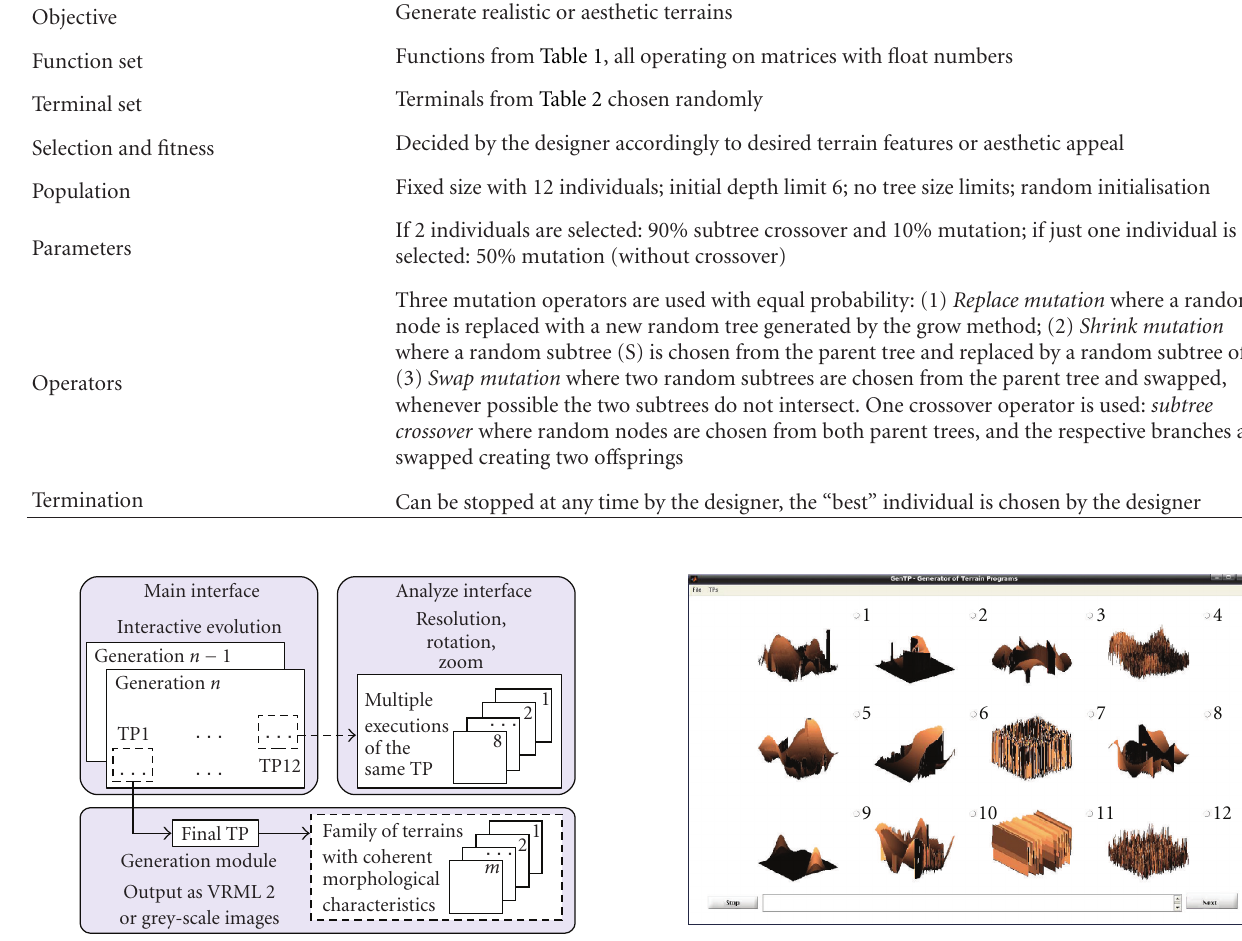
Figure 7: GenTP ’s functional modules. Figure 8: GenTP main user’s